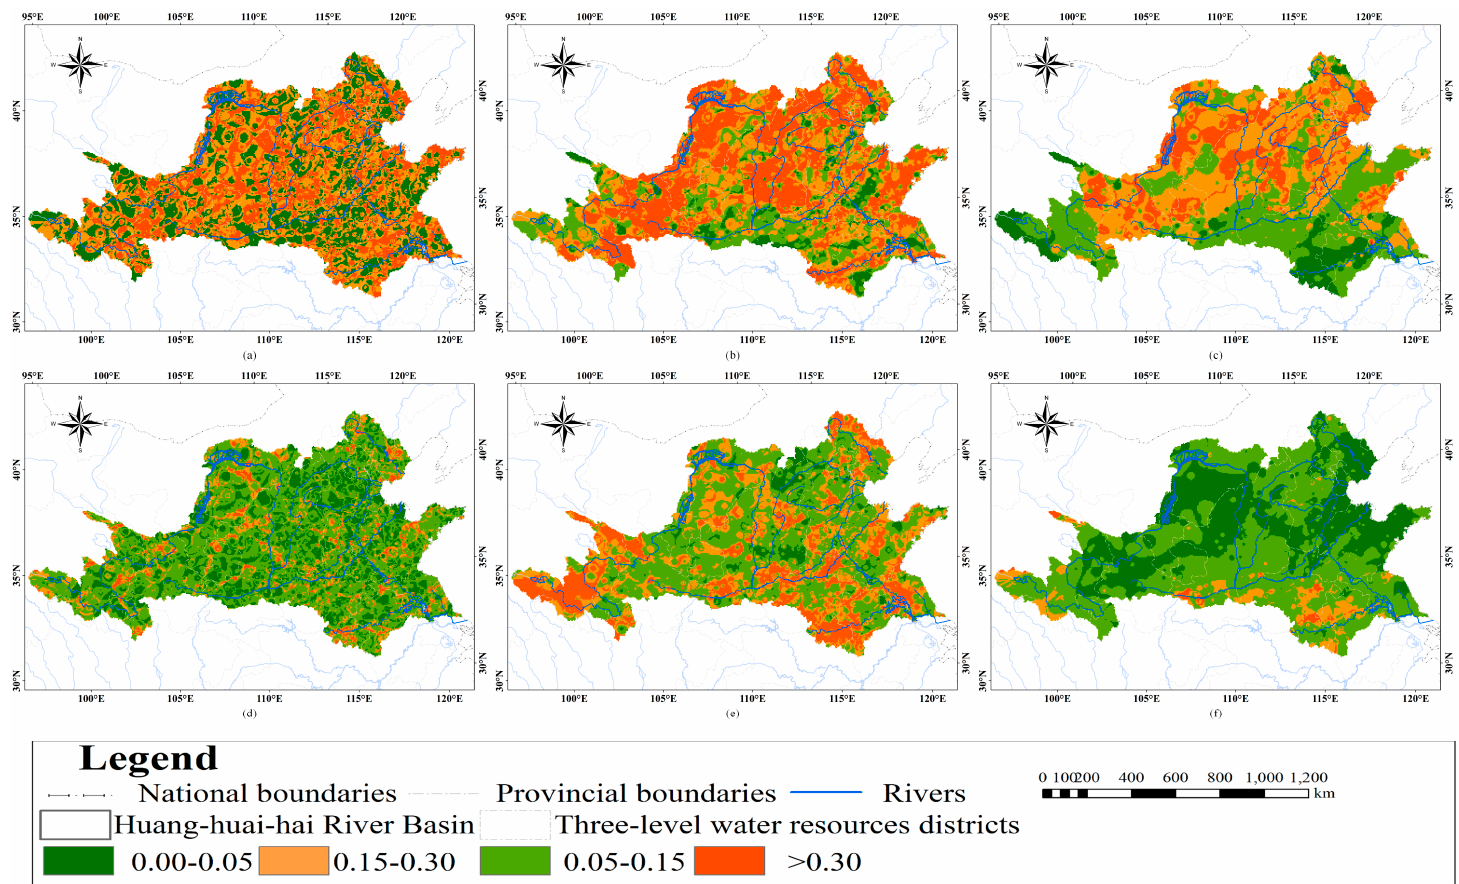
Figure 6. Yearly frequency of Drought in Different Categories: ( a ) yearly frequency of slight drought, 1961–1979; ( b ) yearly frequency of moderate drought, 1961–1979; ( c ) yearly frequency of severe drought, 1961–1979; ( d ) yearly frequency of slight drought, 1980–2011; ( e ) yearly frequency of moderate drought, 1980–2011; and ( f ) yearly frequency of severe drought, 1980–2011.